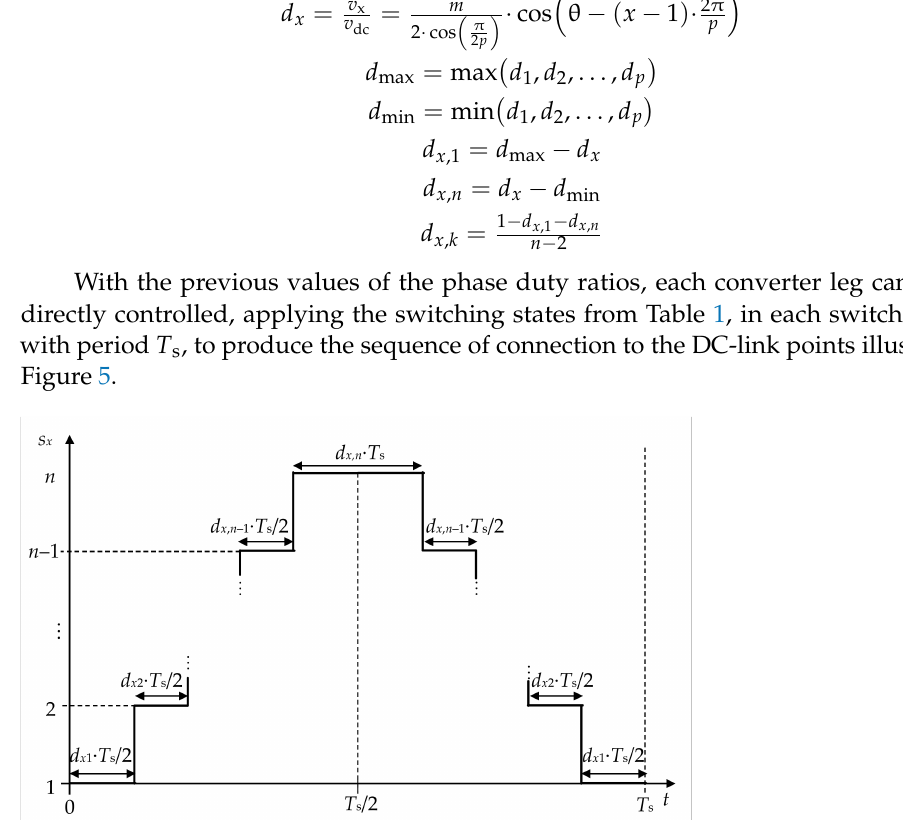
Figure 5. Sequence of connection of each leg to the DC-link points over a switching